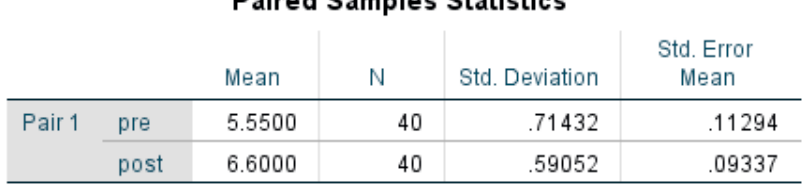
Figure 3. Paired Samples Statistics.